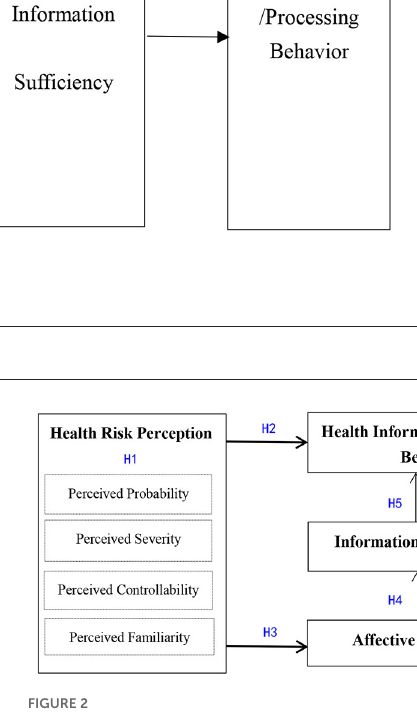
FIGURE2 The health risk perception and health information search behavior research